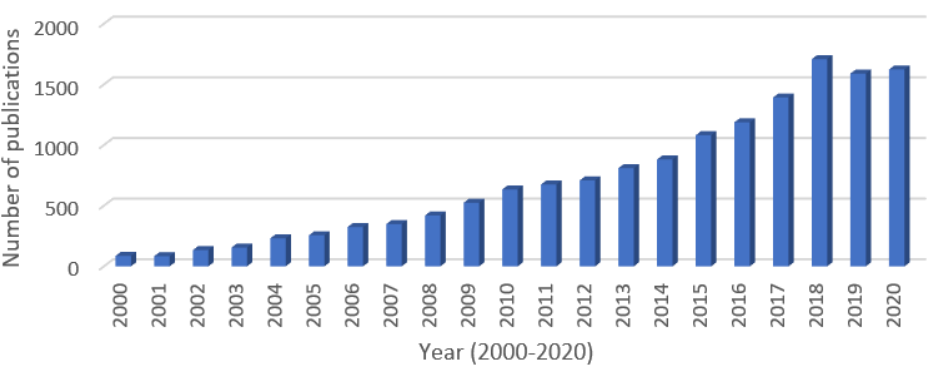
Figure 1. Growth of scientific output from 2000 to 2020 available at National Digital Science Library (http://www.ndsl.kr/).